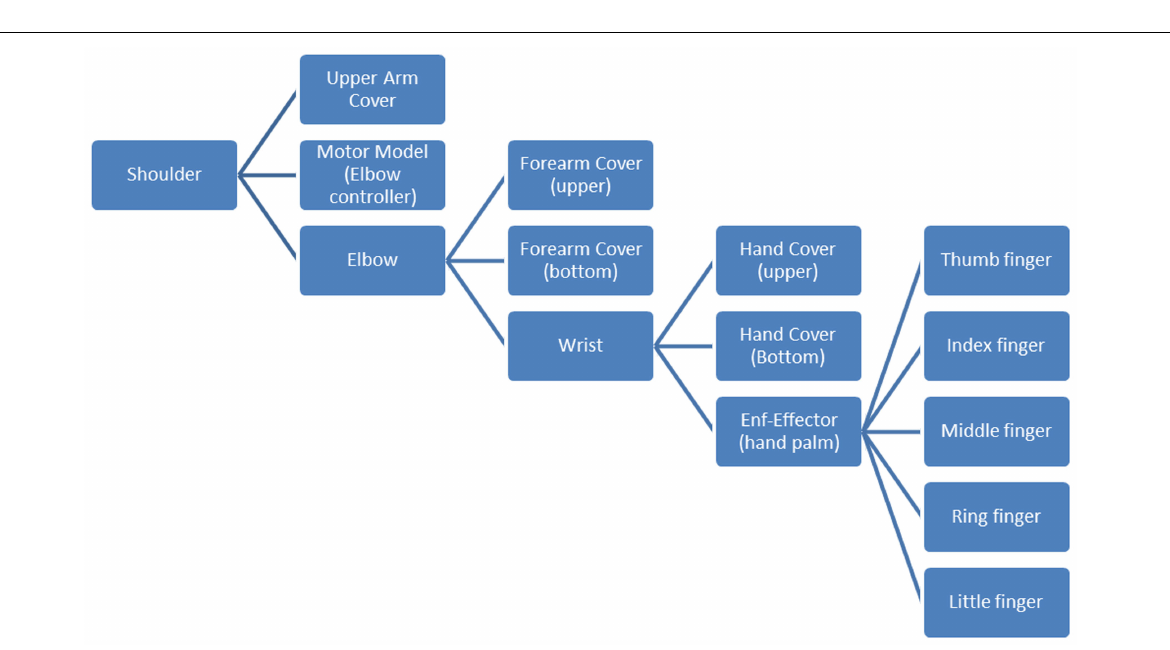
details in Vicente et al. (2015). Moreover, at each time instant we render only the robot parts that are visible by the robot cameras using a shader in the graphics pipeline, instead of rendering the whole robot appearance. A hierarchical tree of the robot kine- matics is defined where each node has a reference frame attached and a pivot point that is used to perform the rotation of this hierarchical object structure (See Figure 11 ). In other words, this tree represents the relationship between the several objects in the model (i.e., the robot body parts). For instance, the fingers are coupled with the robot hand, so that if the hand moves, the fingers will move along with it and update their absolute position in the world, maintaining the relative pose in the hand reference